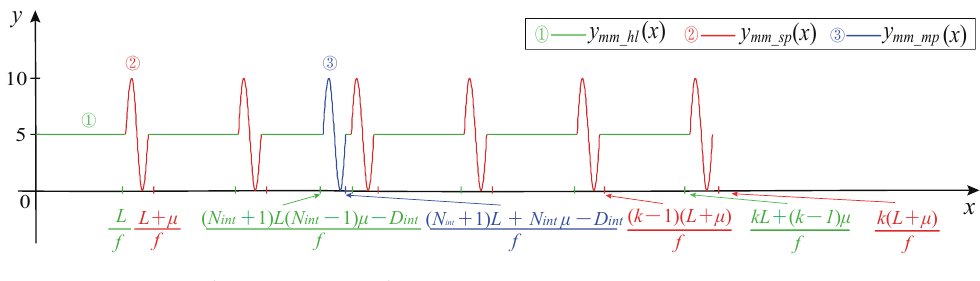
Figure 13. Magnetoelectric CMP